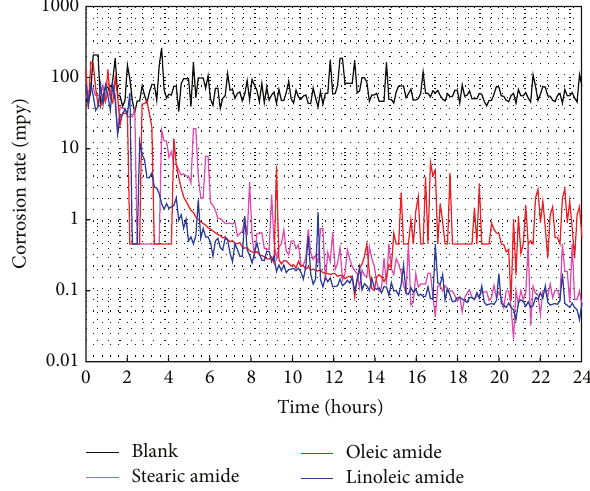
Figure 16: Variations of corrosion rate as determined by HDA measurements ( monitoring real-time ) with time for carbon steel exposed to CO 2 -saturated (3% NaCl + diesel) emulsion at 50 ∘ C,with the different fatty-amides.